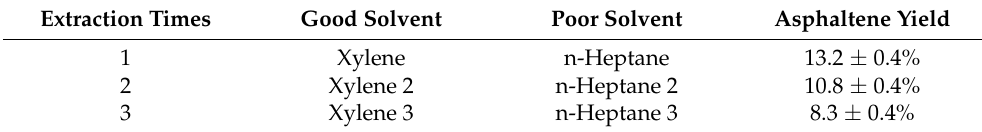
Table 6. Yields of extracted asphaltenes using recovered solvents at different extraction times.